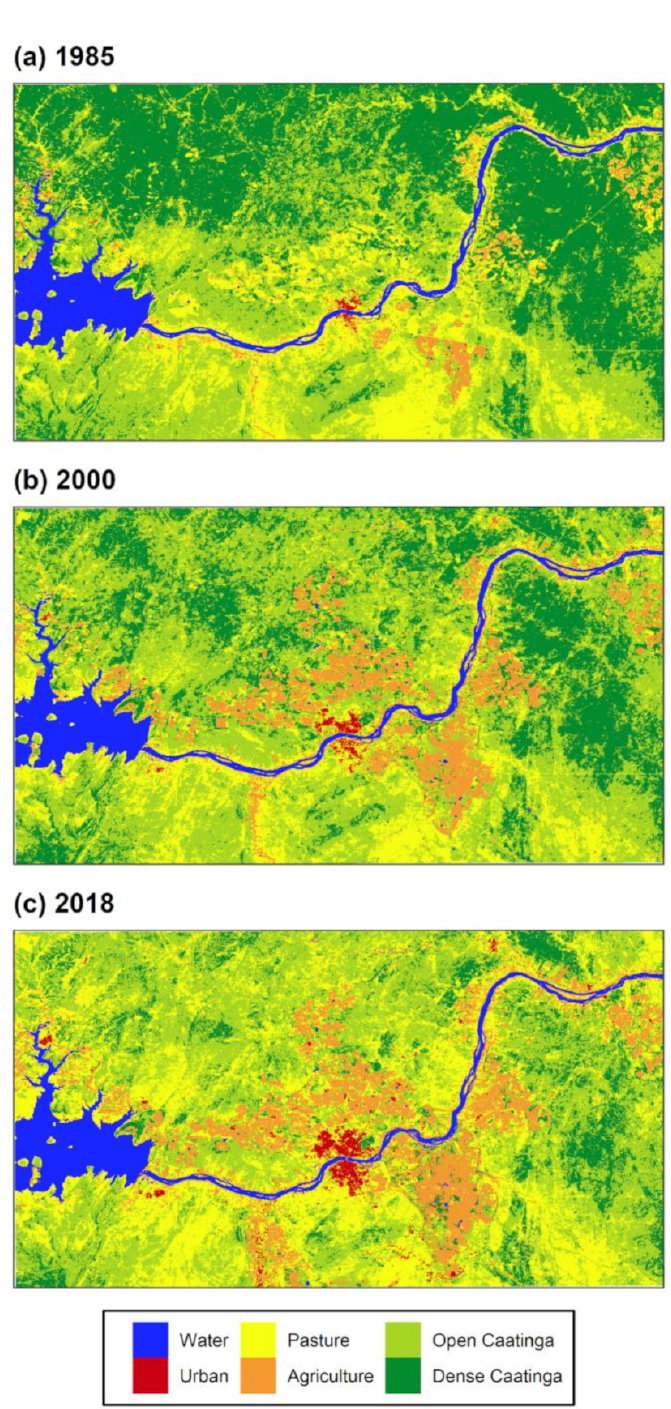
Figure 2. Changes in the landscape composition of the study area for the years: ( a ) 1985, ( b ) 2000 and ( c )